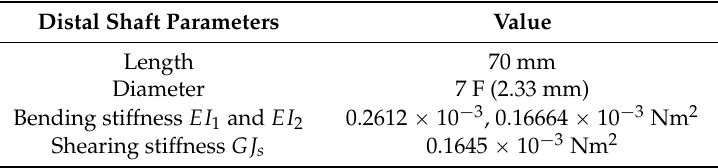
Table 2. Specifications of cardiac ablation